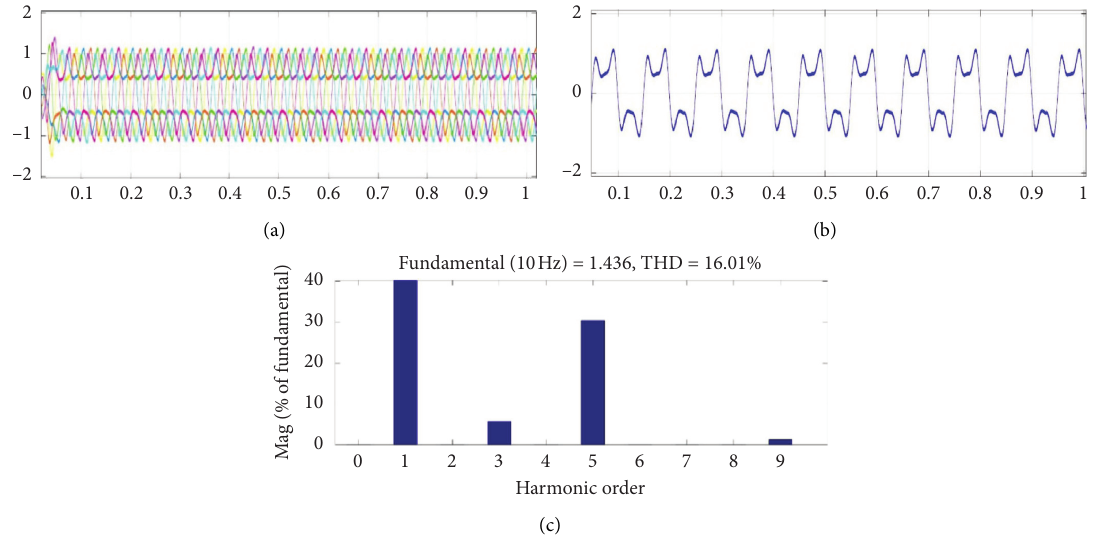
Figure 8: Simulation results of NFV-SVPWM, (a) seven-phase current waveform, (b) a phase current waveform, (c) FFT